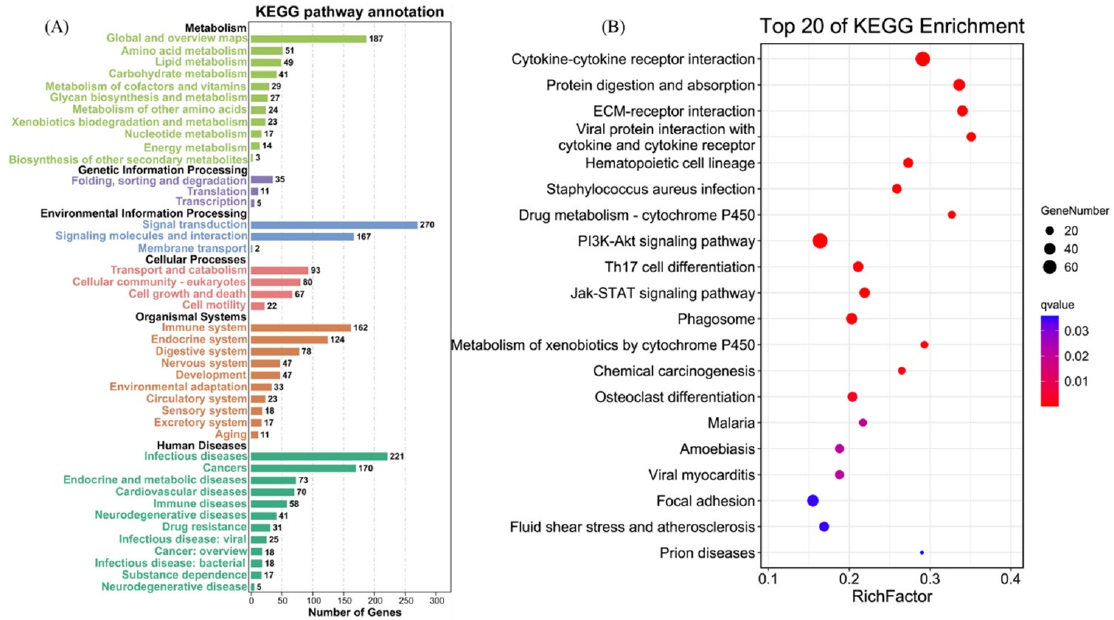
Figure 6. KEGG pathway enrichment analysis of DEGs. ( A ) KEGG pathway annotation and classification of DEGs in gills. ( B ) Scatterplot of top 20 KEGG enrichment pathways of DEGs.